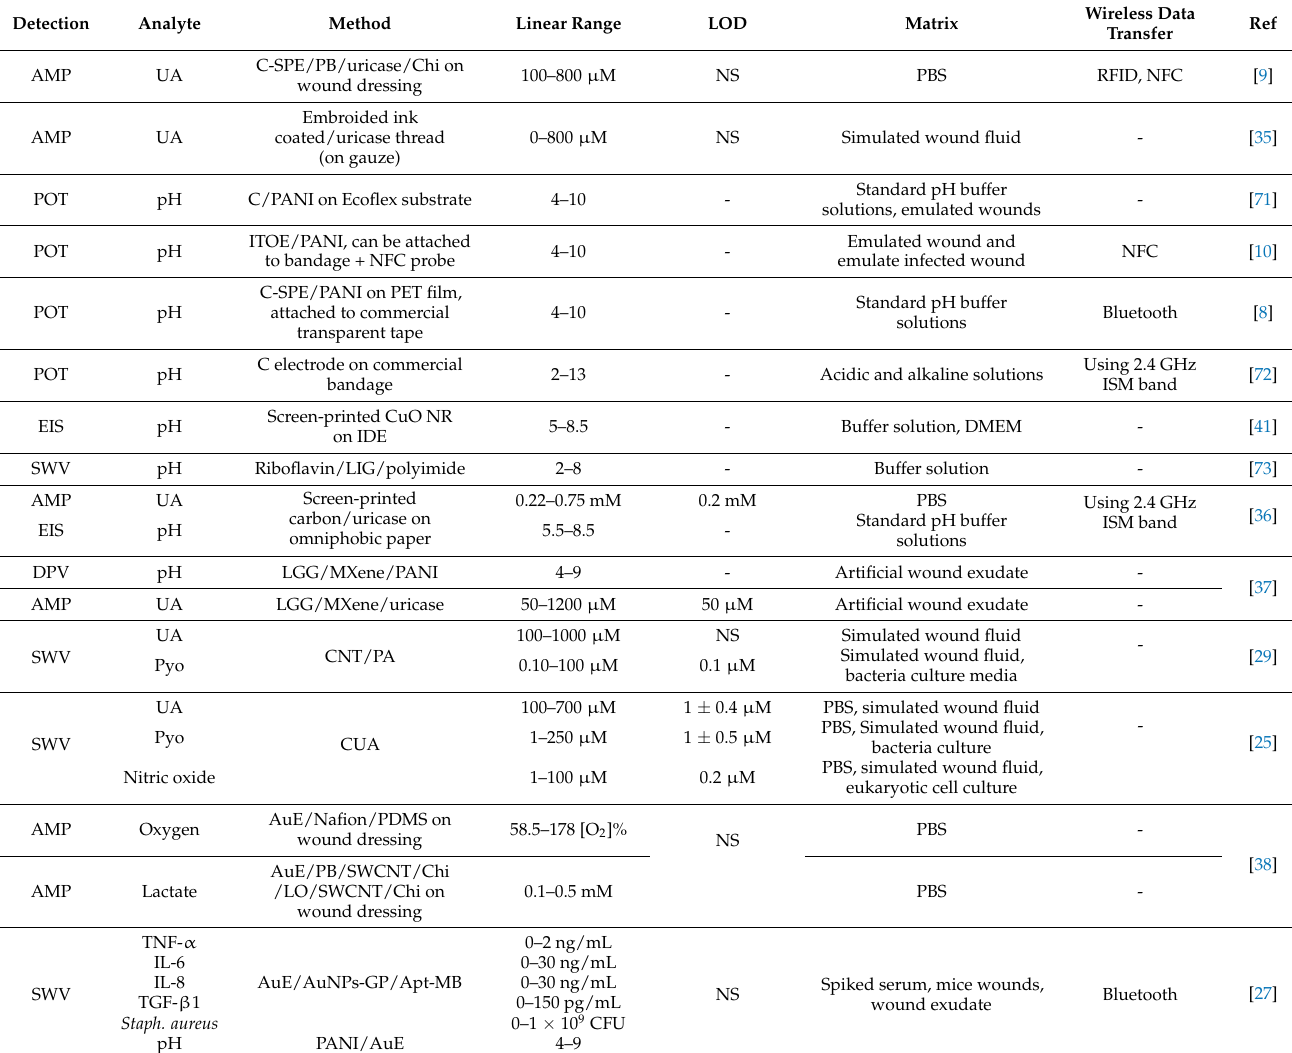
Table 3. Examples of electrochemical wearable and disposable sensors for wound infection biomarker